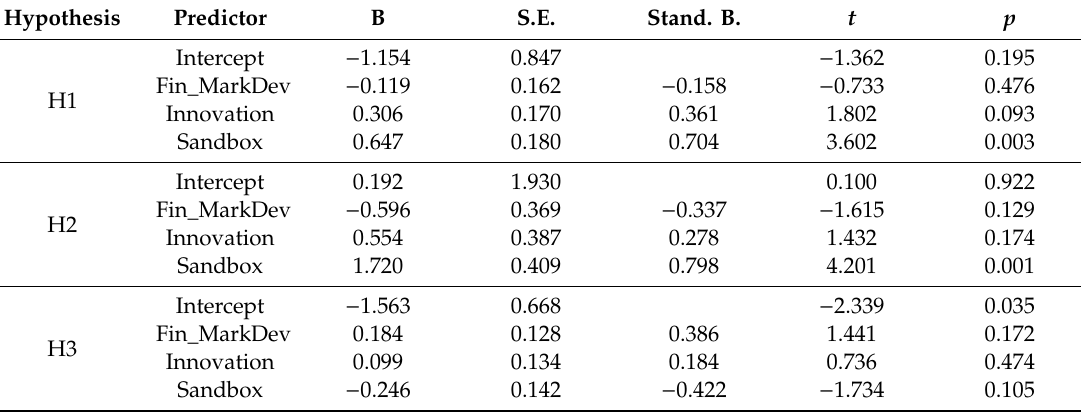
Table 12. Model 3 coe ffi